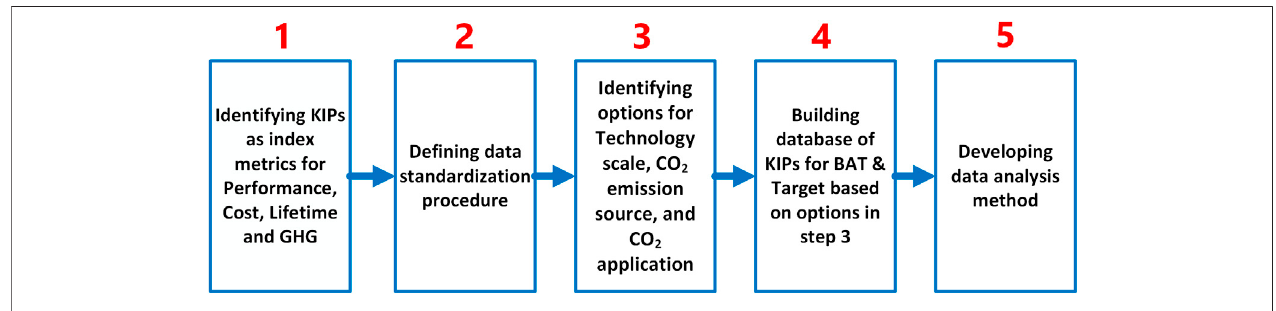
FIGURE 3 | Steps of creating TDM tool.